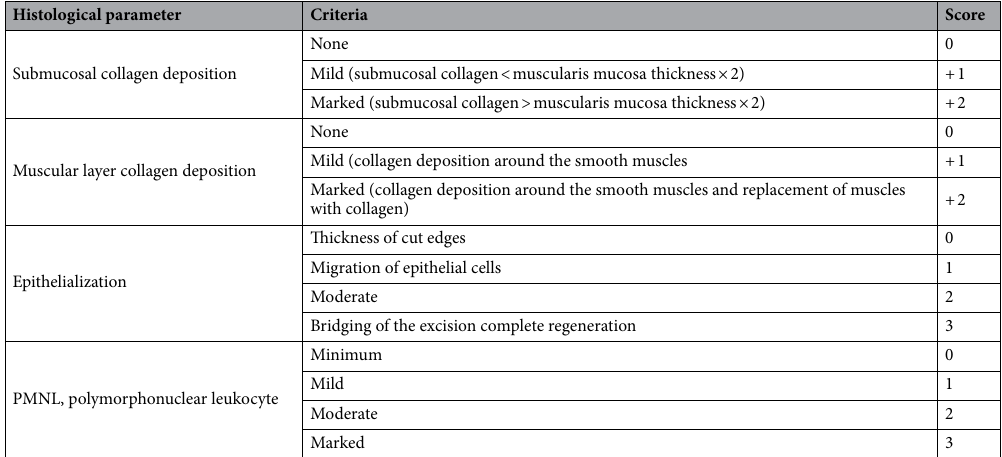
Table 2. Description of the histopathological scores of the semi-quantitative evaluation.